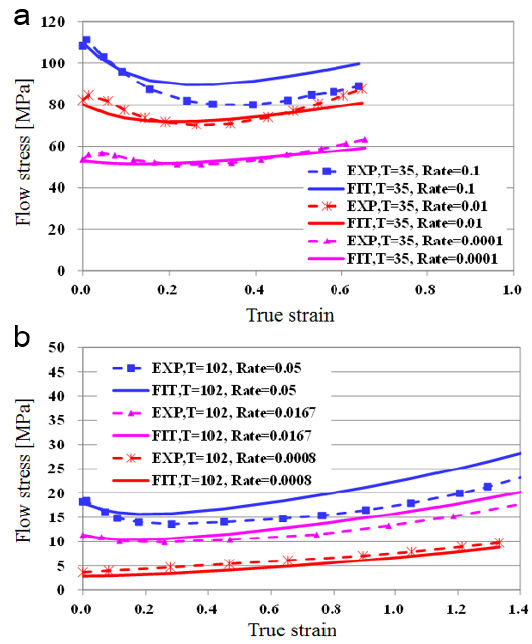
Figure 5. Fitting results at ( a ) low temperature (35 °C) and ( b ) high temperature (102 °C).